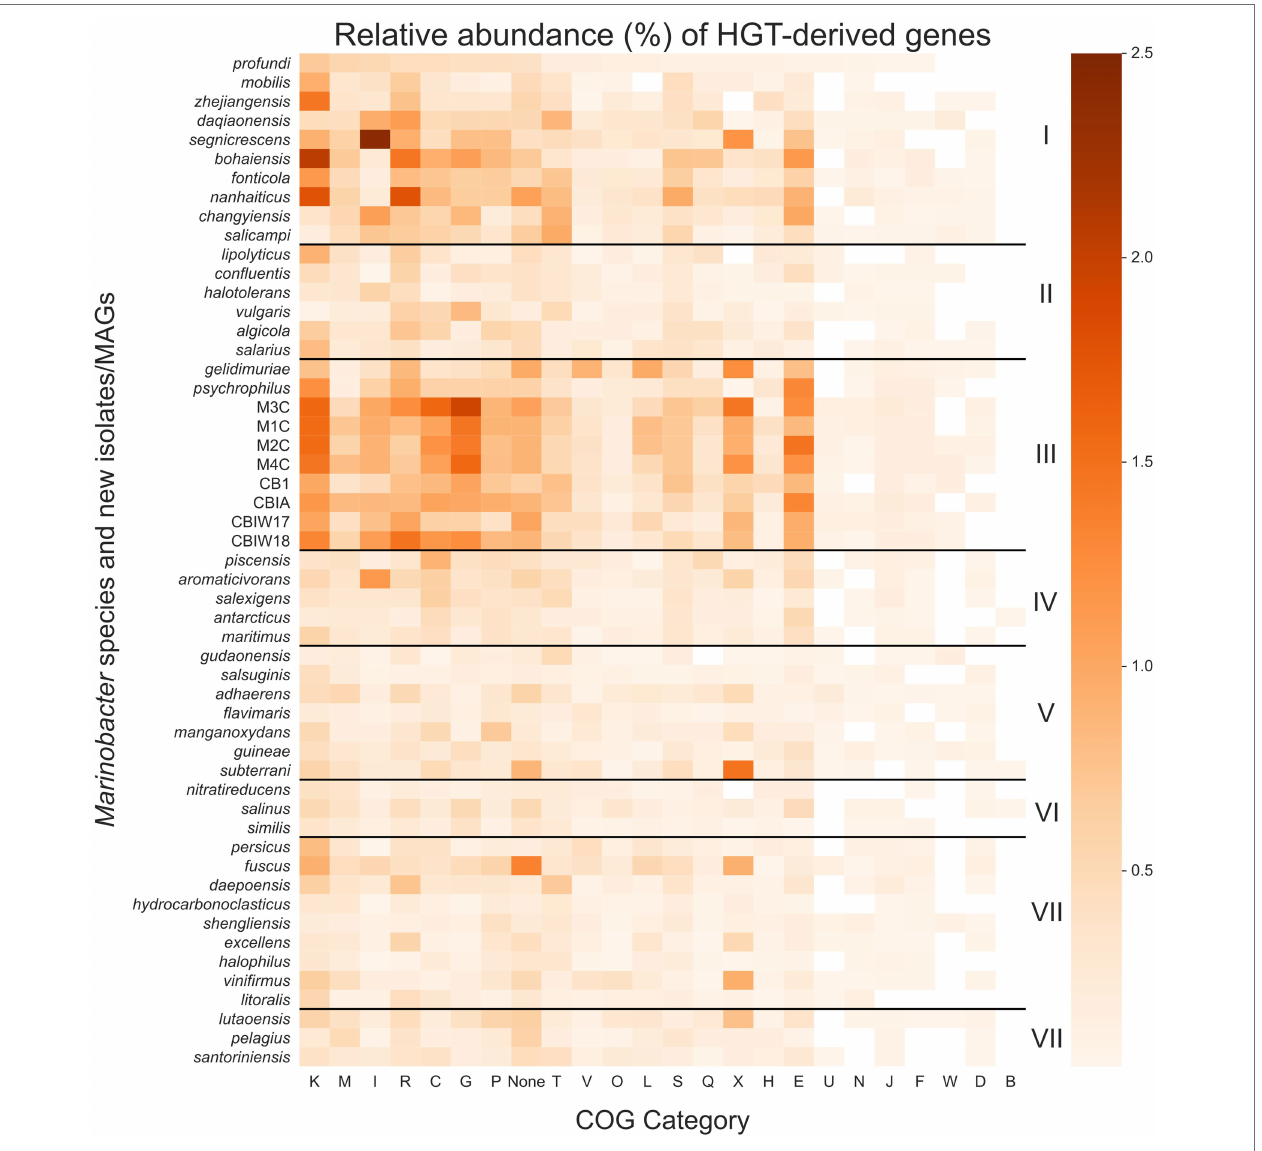
FIGURE 5 | Heatmap of the relative abundance of genes derived by horizontal gene transfer (HGT) in each Marinobacter genome. Each row represents a single Marinobacter genome, and each column represents a COG category. Normalization was done by counting the number of potentially HGT-derived genes, dividing by the total number of genes in a genome, and converting to a percentage. The colormap ranges from 0% (lightest orange) to 2.5% (darkest orange). Black horizontal lines separate the heatmap into clades, with clade numbers I–VIII listed between the heatmap and scale bar. COG categories are defined as follows: K for transcription; M, cell wall/membrane/envelope biogenesis; I, lipid transport and metabolism; R, general function prediction only; C, energy production and conversion; G, carbohydrate transport and metabolism; P, inorganic ion transport and metabolism; T, signal transduction mechanisms; V, defense mechanisms; O, posttranslational modification, protein turnover, chaperones; L, replication, recombination and repair; S, function unknown; Q, secondary metabolites biosynthesis, transport and catabolism; X, mobilome: prophages, transposons; H, coenzyme transport and metabolism; E, amino acid transport and metabolism; U, intracellular trafficking, secretion, and vesicular transport; N, cell motility; J, translation, ribosomal structure and biogenesis; F, nucleotide transport and metabolism; W, extracellular structures; D, cell cycle control, cell division, chromosome partitioning; B, chromatin structure and dynamics; and None, no COG annotation